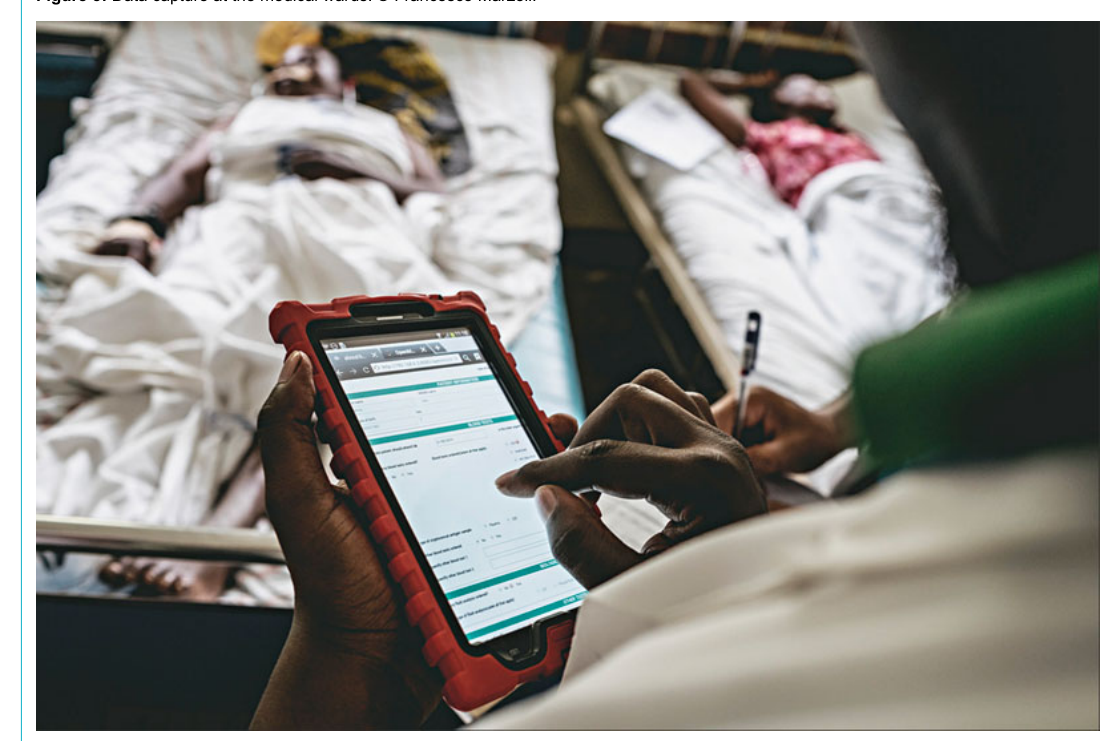
Figure 5: Data capture at the medical wards. © Francesco